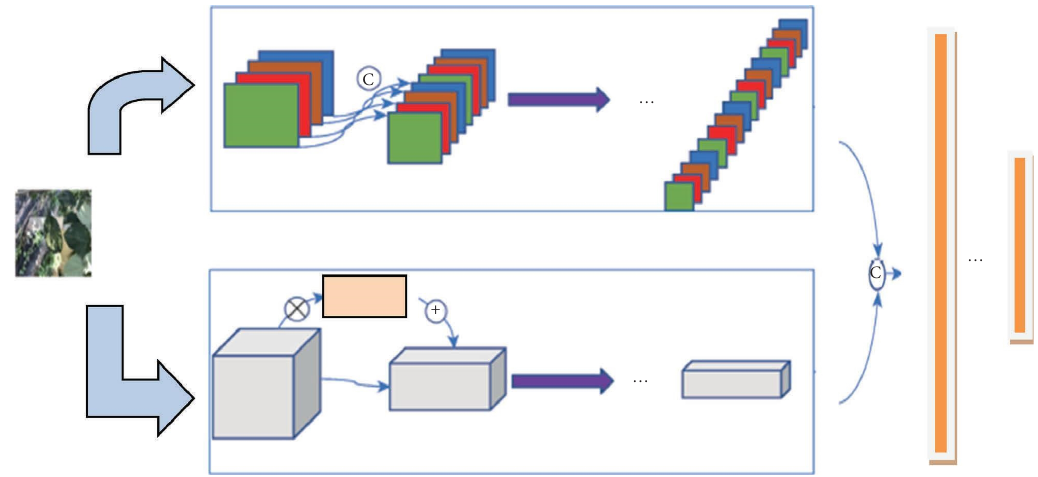
Figure 2: DBNet network structure